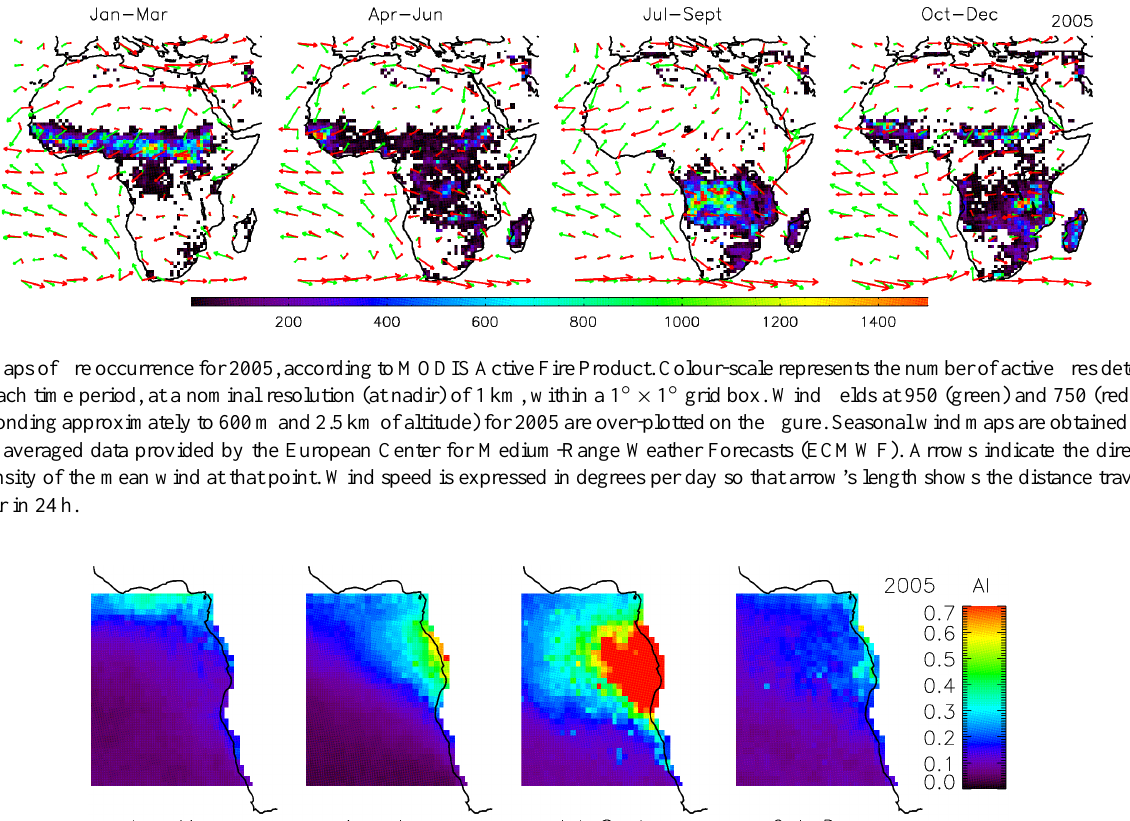
Fig. 4. Maps of seasonally averaged measurements of Angstrom exponent (ANG), for 2005.